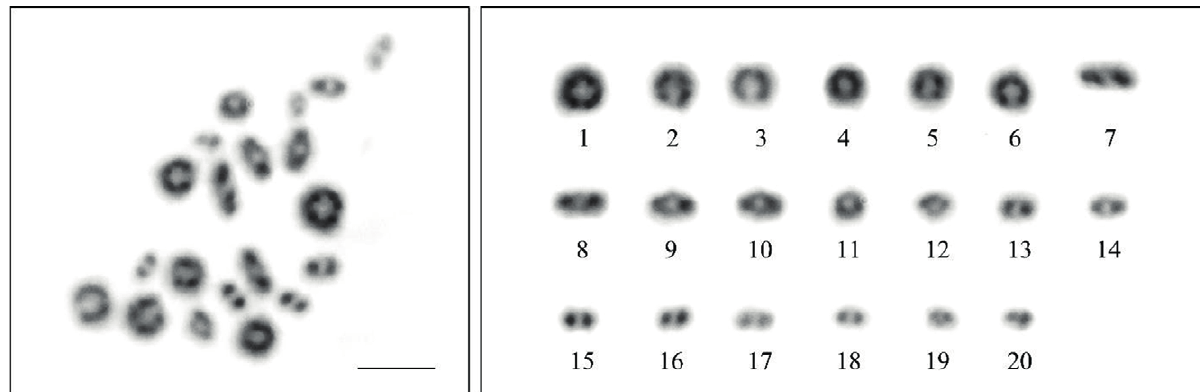
Figure 3. Metaphase I chromosome plate and karyotypes of Cyrtodactylus inthanon , n =20 by conventional staining technique. Scale bars indicate 5